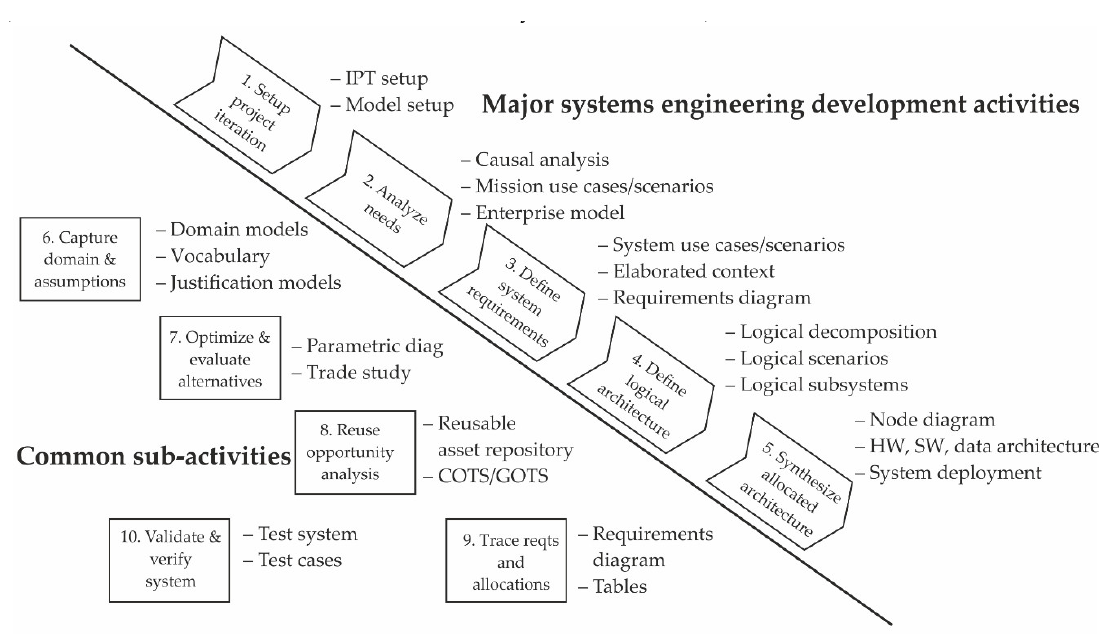
Figure 3. INCOSE OOSEM in Model-Based Systems Engineering.